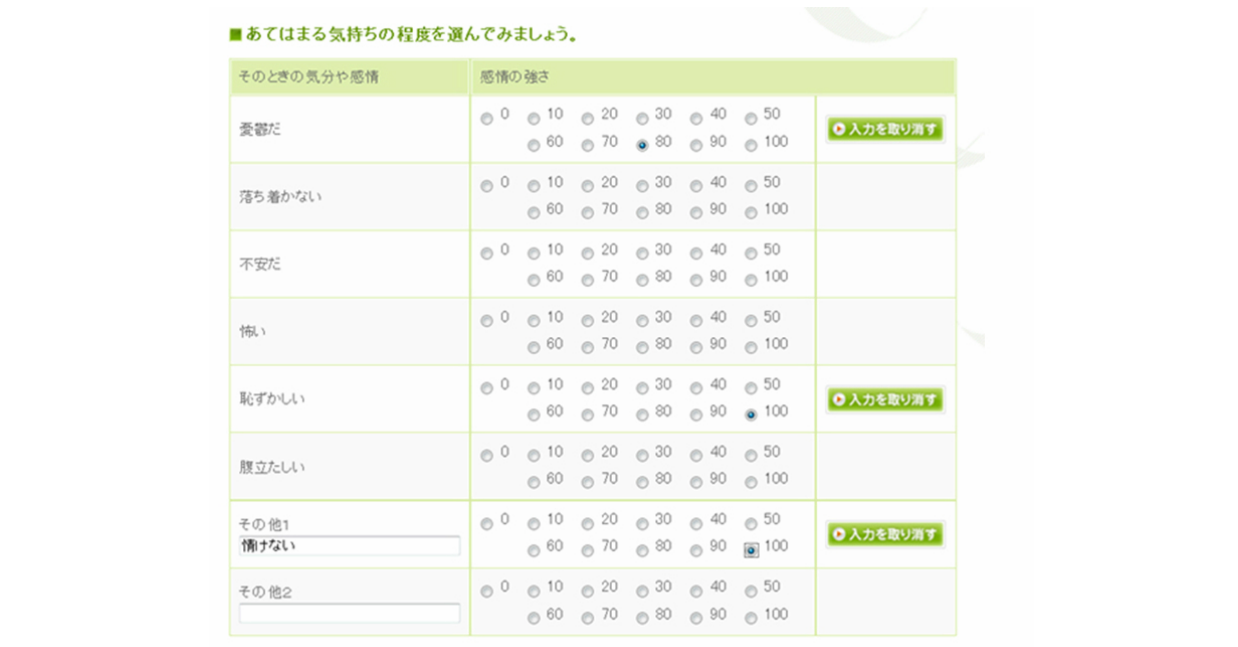
Figure 2. Program